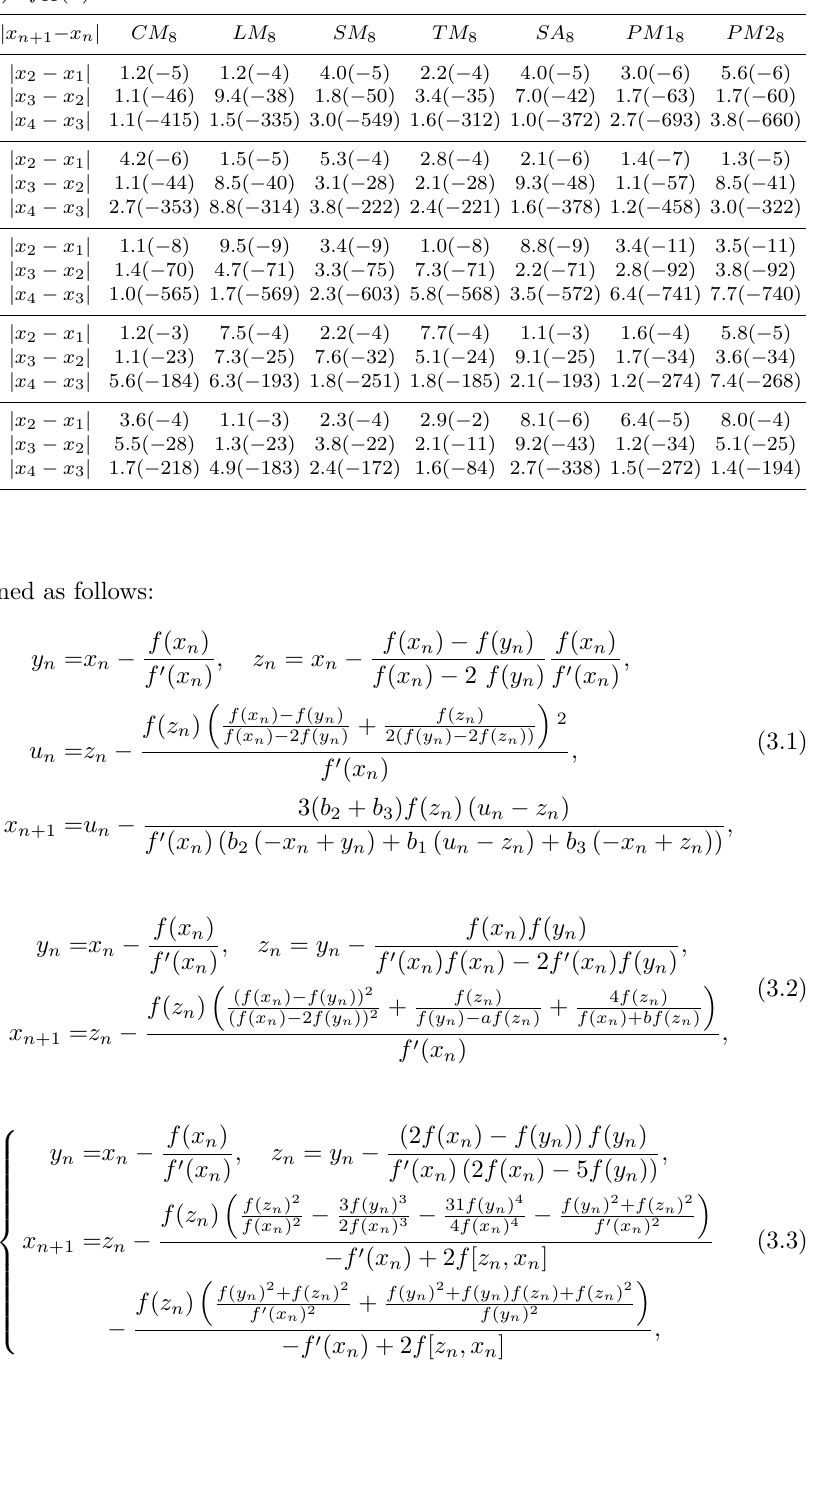
Table 3. Comparison of error in the consecutive iterations on the test examples f 7 ( x ) – f 11 ( x